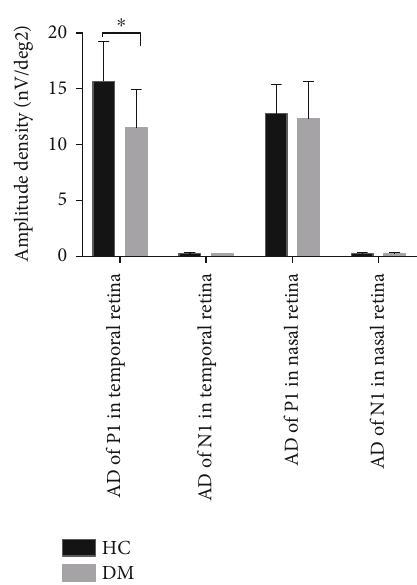
Figure 3: The amplitude of P1 and N1 waves in temporal and nasal retina between HC and DM patients, ∗ p < 0 : 05